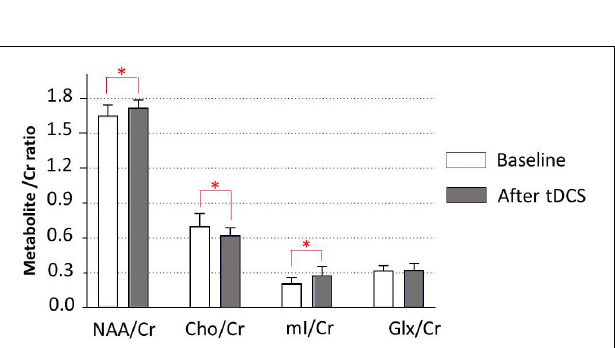
FIGURE 4 | Metabolite changes in the locus coeruleus. Data are presented as means of NAA/Cr, Cho/Cr, mI/Cr, and Glx/Cr concentrations, compared between baseline (before tDCS) and after a 5-day tDCS treatment (day 5). Vertical lines represent SD. ∗ Represents significant difference; ∗∗ p < 0.01, ∗ p <